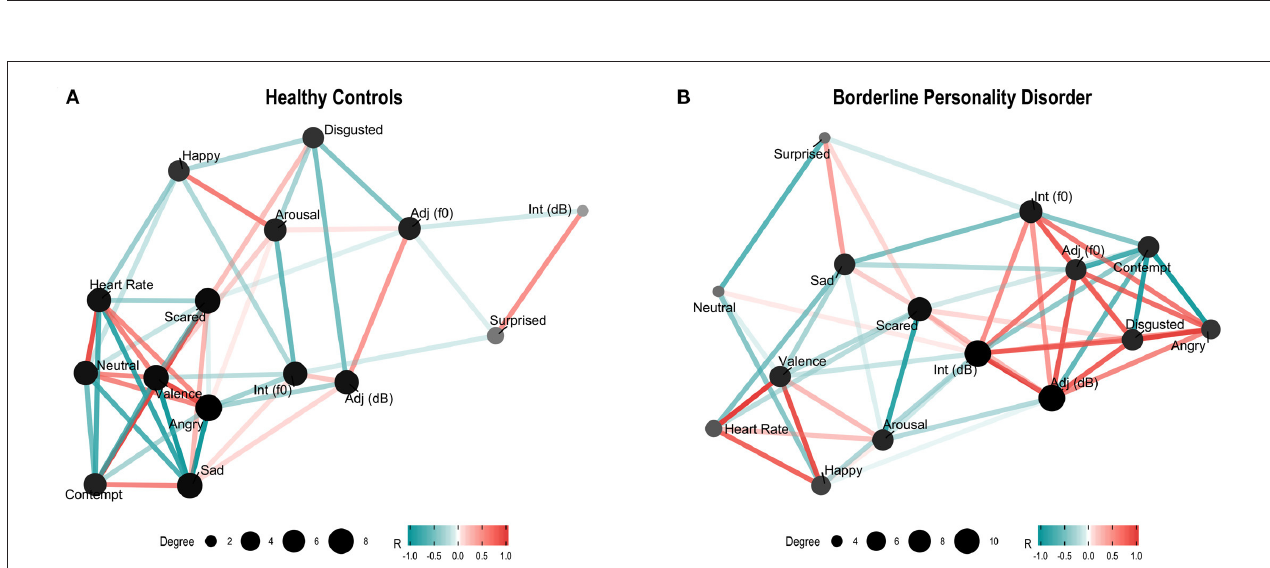
FIGURE 2 | Controls (A) and patients (B) force-directed layout networks among facial expressions, acoustic parameters ( f0–dB ), valence, heart rate, and arousal. The nodes represent recorded variables; their size and color intensity reflect the number of correlations: bigger and darker nodes represent a greater number of relations. Edges connecting pairs of nodes reflect the strength of their correlation. Color intensity (red for positive and blue for negative) reflects the correlation